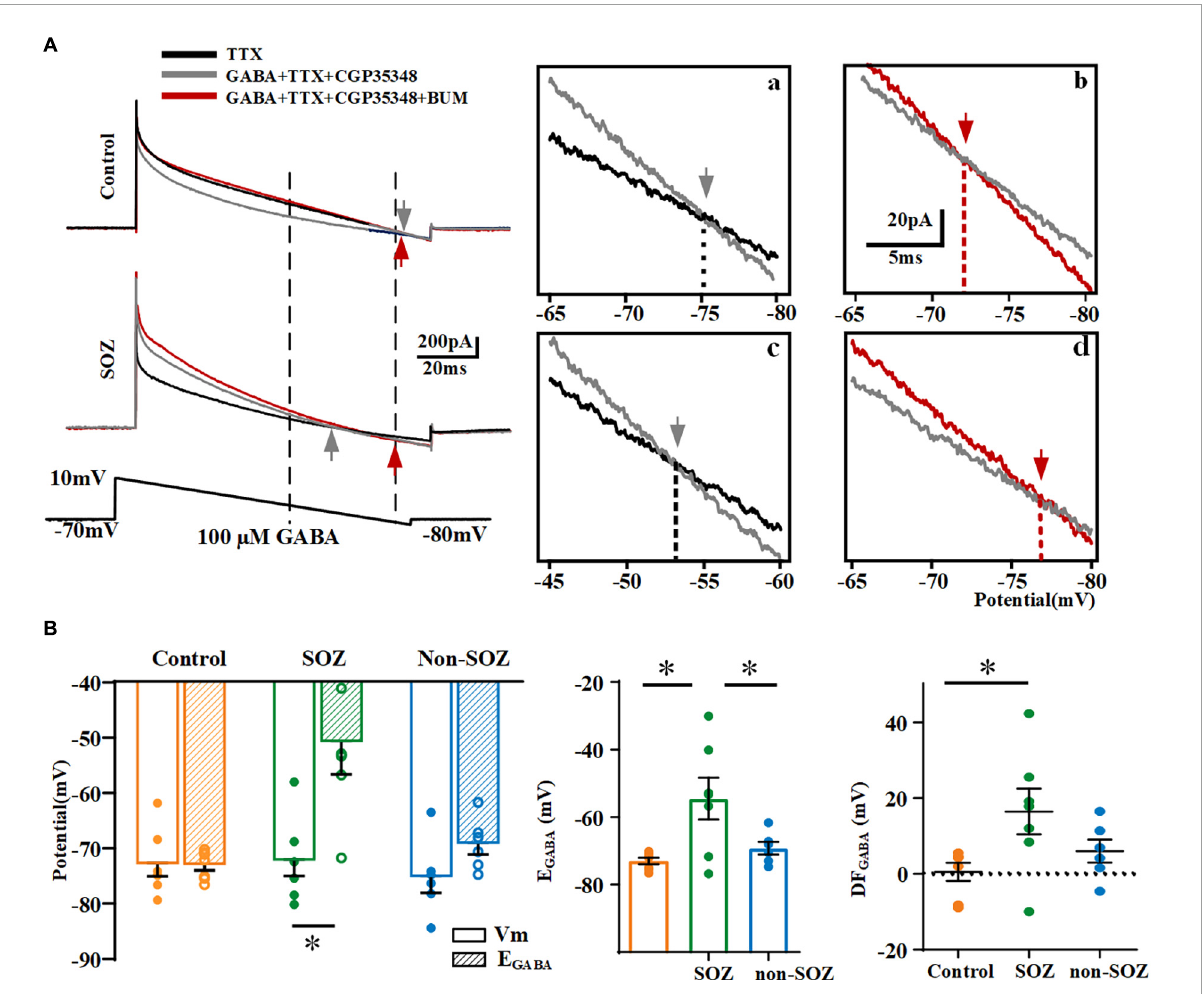
FIGURE4 Comparison of reversal potentials of GABA (E GABA ) across groups. (A) Gramicidin-perforated-patch recordings exhibiting current traces of pyramidal neurons from SOZ (a) and control groups (b) during hyperpolarizing ramps (bottom) in the absence of GABA (black line), with the application of 100 µ M GABA (gray line), and with the application of 100 µ M GABA and 10 µ M BUM (red line). The ramp potential at which the current traces without GABA and with GABA, without BUM and with BUM intersected, represent E GABA (gray arrow in inset) and E BUM (red arrow in inset). Vertical dashed lines intersecting the command potential schematic show the range of command voltage in the boxed area. Insets: expanded traces of boxed regions illustrate the E GABA (gray arrow) and E BUM (red arrow) of a pyramidal neuron in SOZ (a,c) and control groups (b,d) . (B) Summary plot of E GABA and DF GABA across groups. ∗ p < 0.05. Data was shown as mean ±